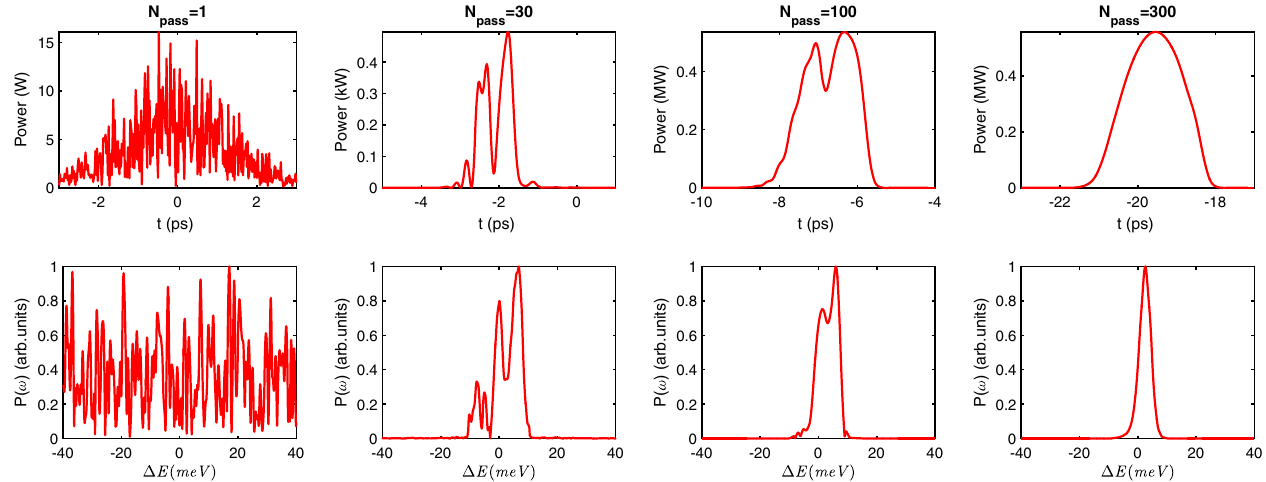
FIG. 10. Snapshots of output radiation pulse for a typical X-ray FELO at 1 . 0 Å. The top and the bottom row show the longitudinal pulse temporal profile and corresponding spectrum respectively